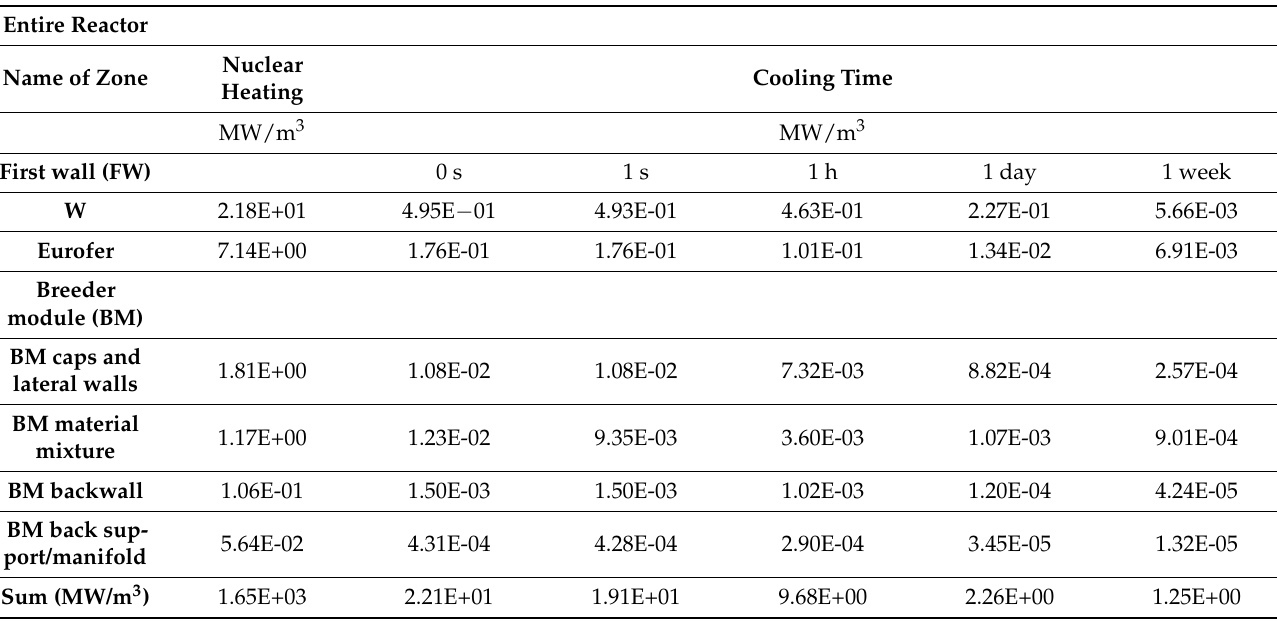
Table 13. Decay heat densities (MW/m 3 ) integrated into the WCLL full reactor [24].